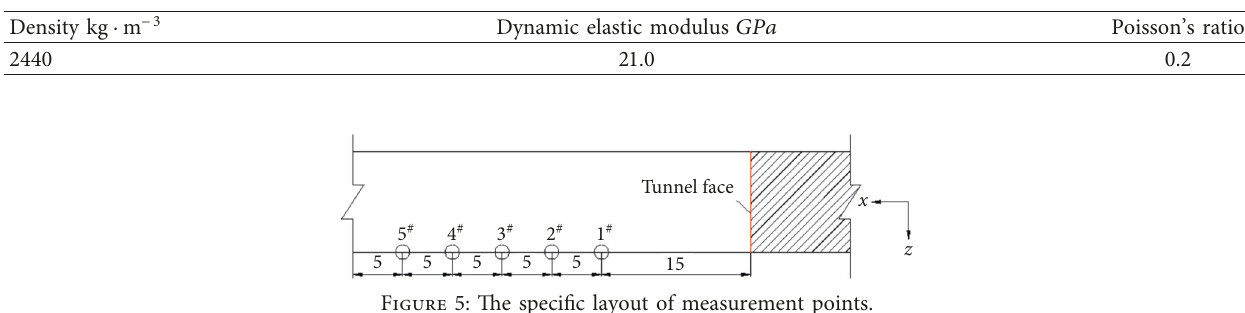
Table 3: The physical and mechanical parameters of the concrete.